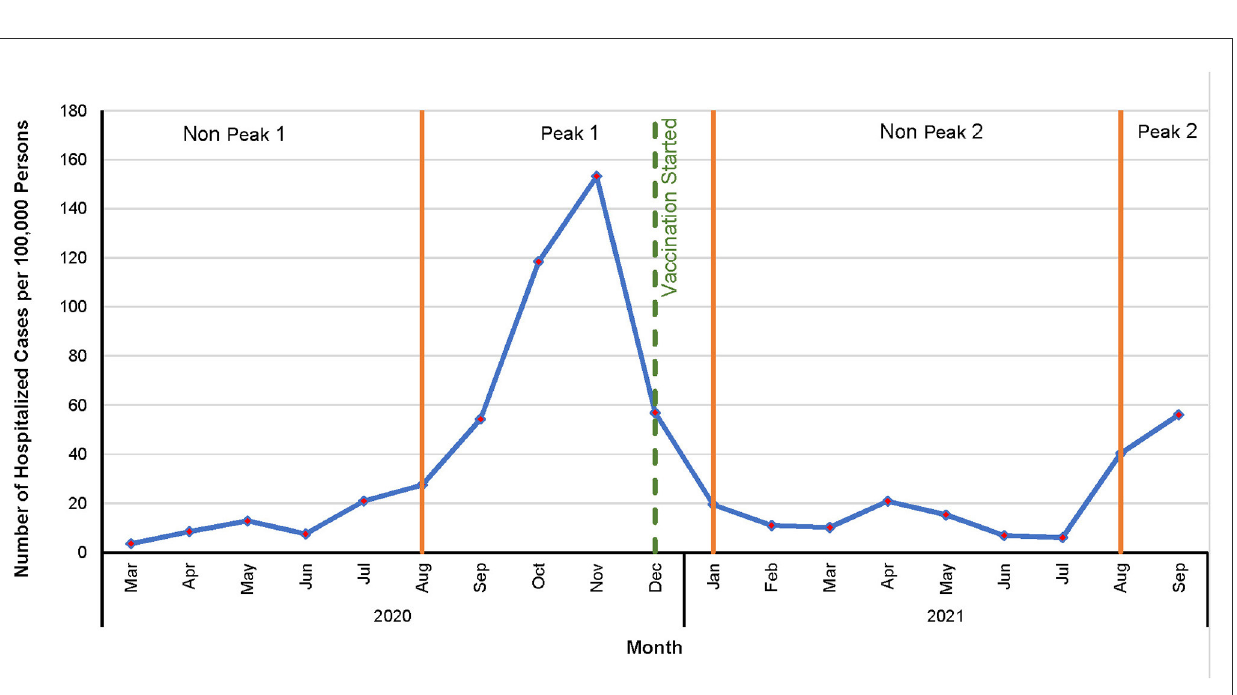
FIGURE4 Temporal patterns of COVID-19 hospitalization risks in North Dakota, March 2020–September